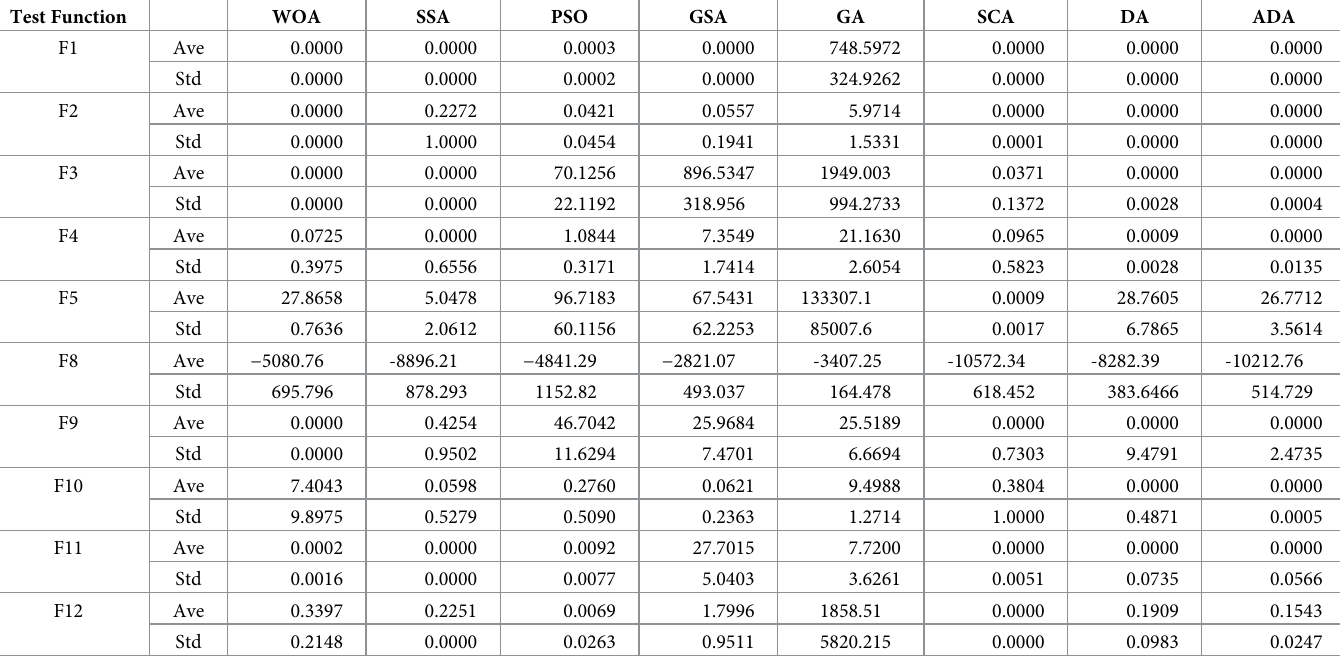
Table 4. Optimization results of the 8 different algorithms including ADA on 12 benchmark functions. Test Function